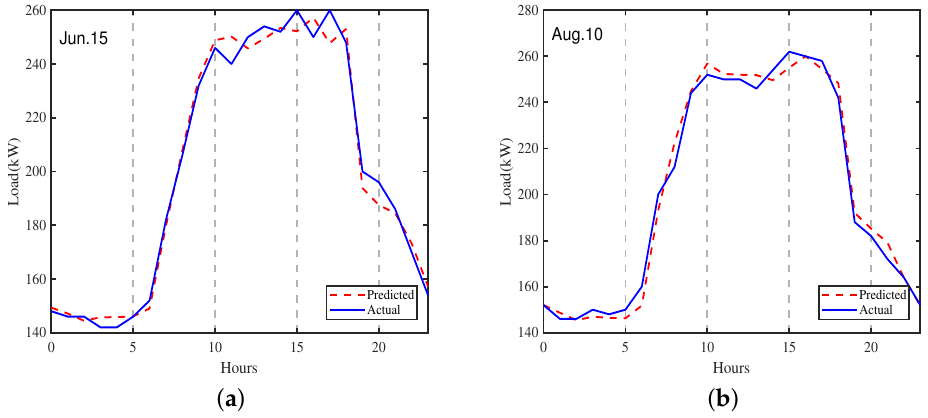
Figure 5. Predicted load and actual load for test days of the RSF building. ( a ) Prediction for 15 June 2011; ( b ) Prediction for 10 August